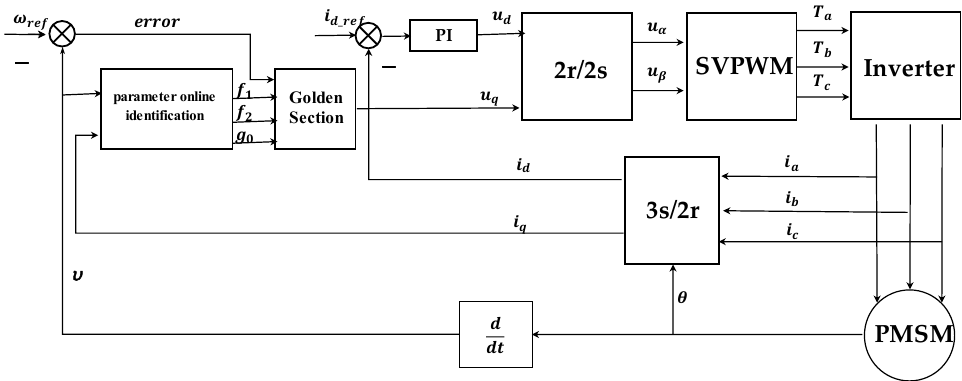
Figure 2. Golden-section speed adaptive system structure diagram.